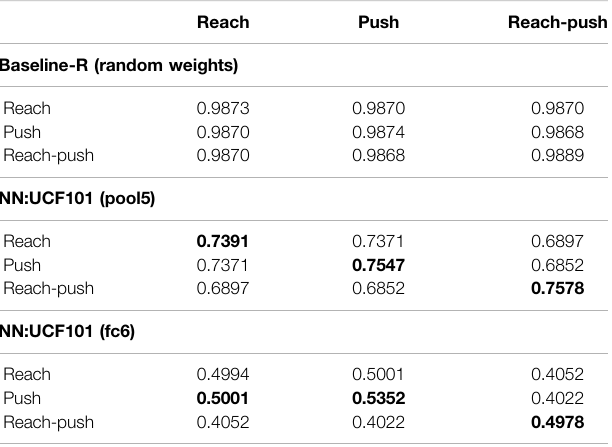
TABLE 3 | Class similarity scores. The intraclass similarity (diagonal values) are greaterthantherestofthevalues,indicatingadequatetask-discriminationand domain-invariance.